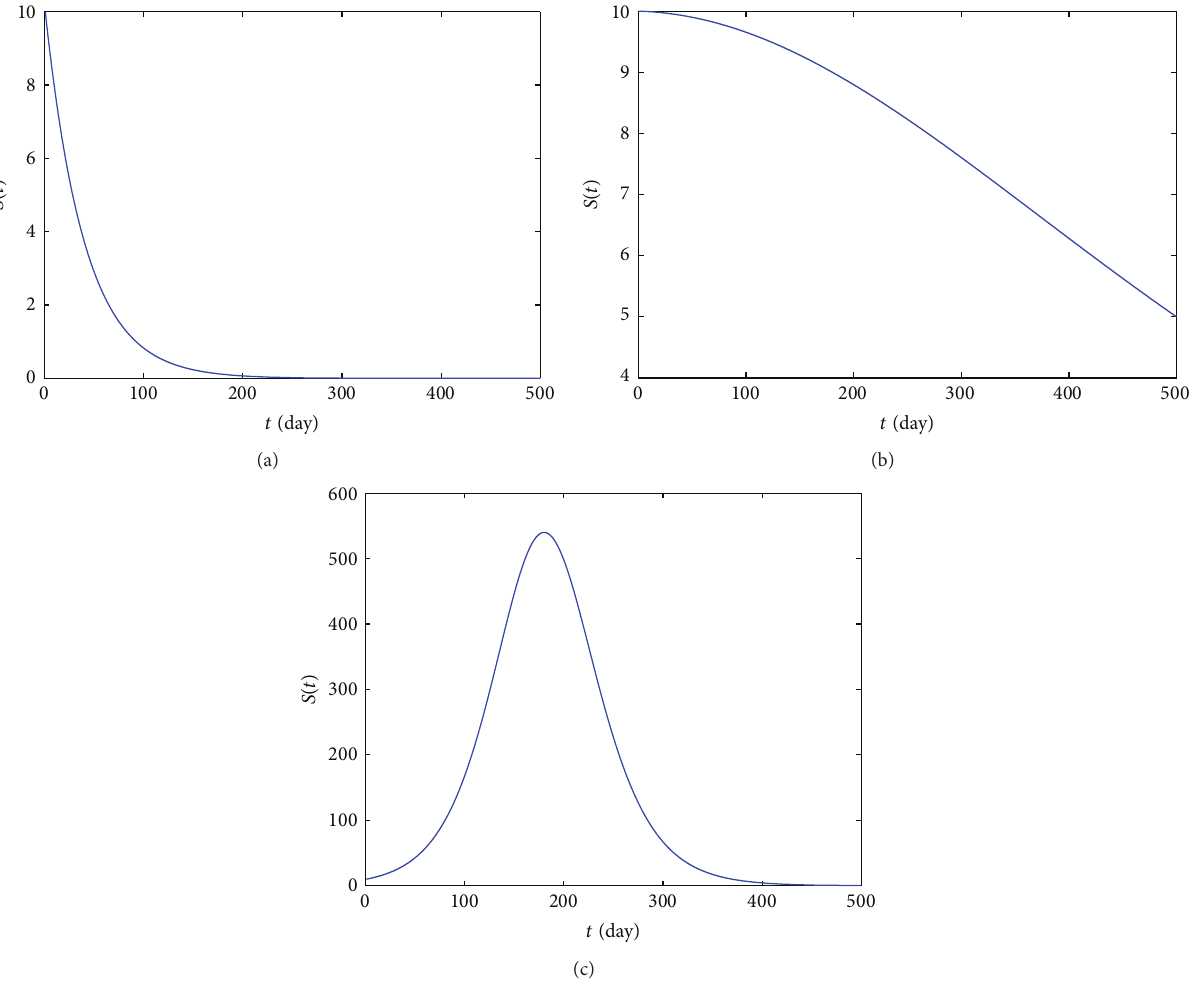
Figure 3: The number of the spreaders in terms of time under different condition, (a) 𝑑𝐼/𝑑𝑡 = −0.2506 , where 𝛽 = 0.15 , (b) 𝑑𝐼/𝑑𝑡 ≈ 0 , where 𝛽 = 0.200005 , and (c) 𝑑𝐼/𝑑𝑡 = 0.2994 , where 𝛽 = 0.26 . The other parameter values and the initial values can be seen in Table